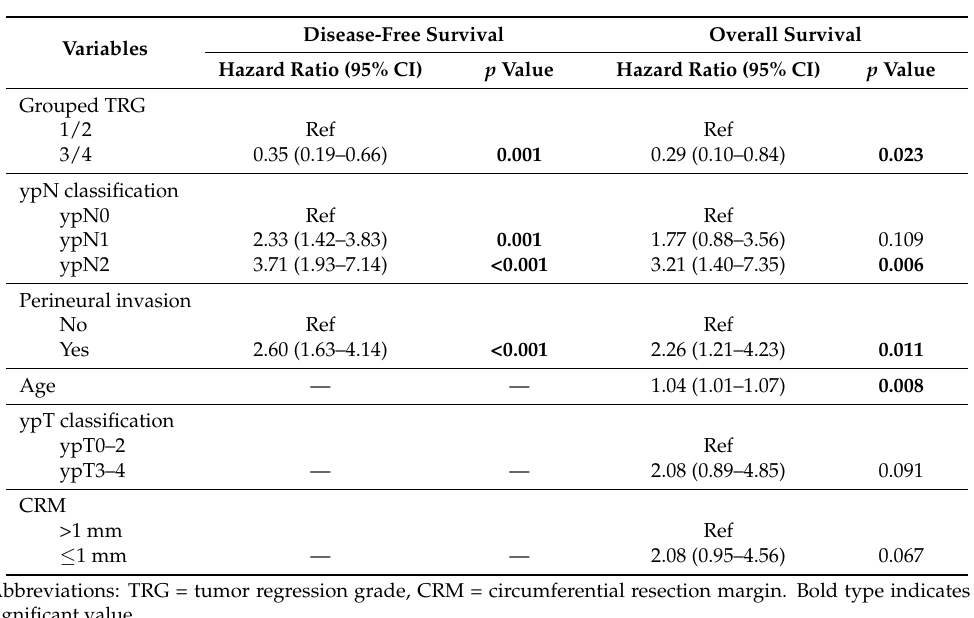
Table 3. Multivariate analysis for prognostic